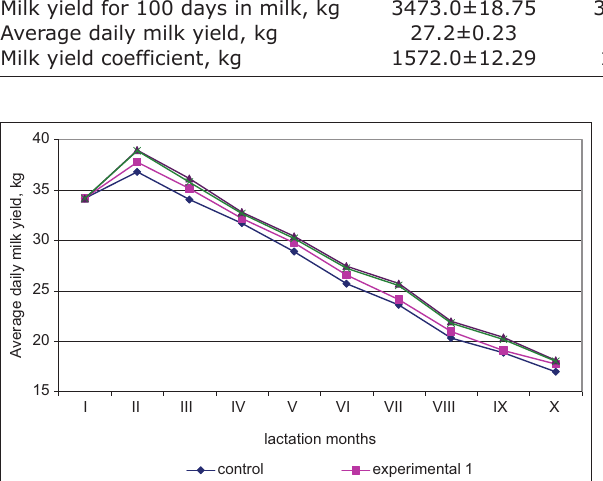
Figure-2: Lactation curves by lactation